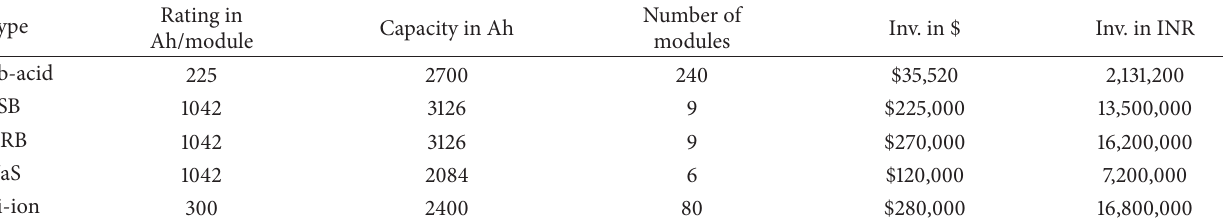
Table 6: Sizing of batteries without optimization.